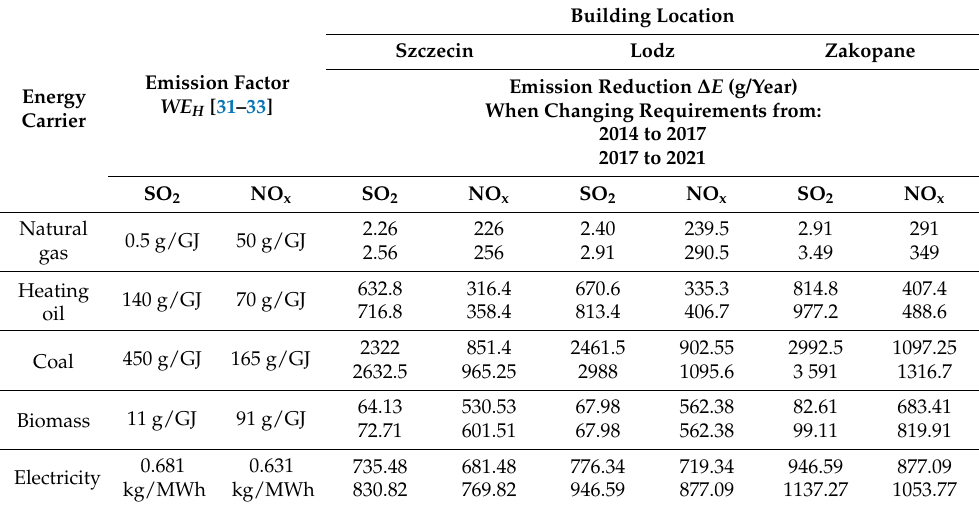
Table 10. Reduction of SO 2 and NO x emissions in the analyzed variants.